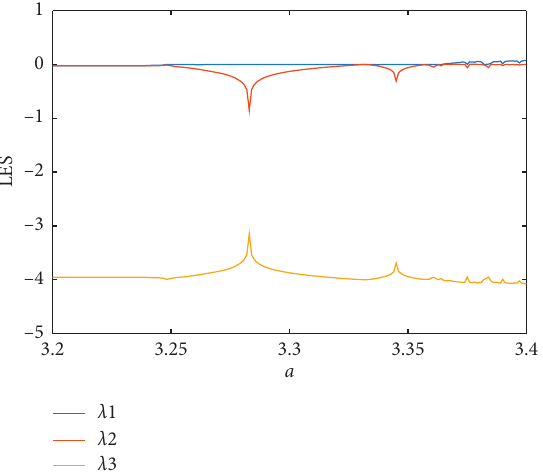
Figure 5: Lyapunov exponents spectrum of 3D jerk system (1) for b � 1 and c �